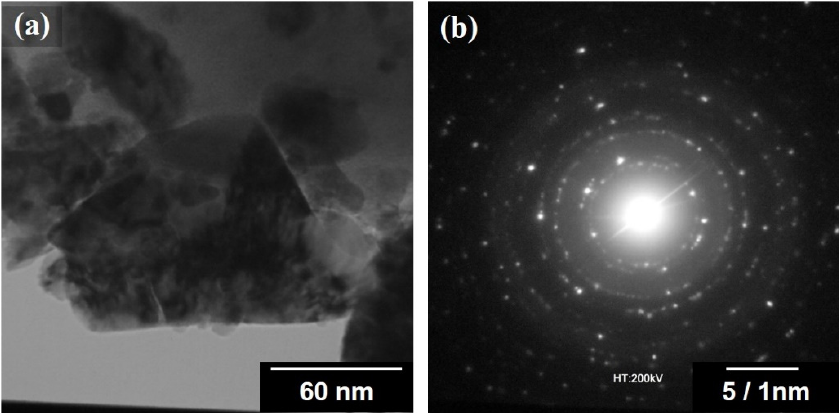
Figure 2. TEM morphology of the nanocrystalline AlCrFeCoNi HEA powder ( a ) and selected area electron diffraction pattern of diffraction spots ( b ).